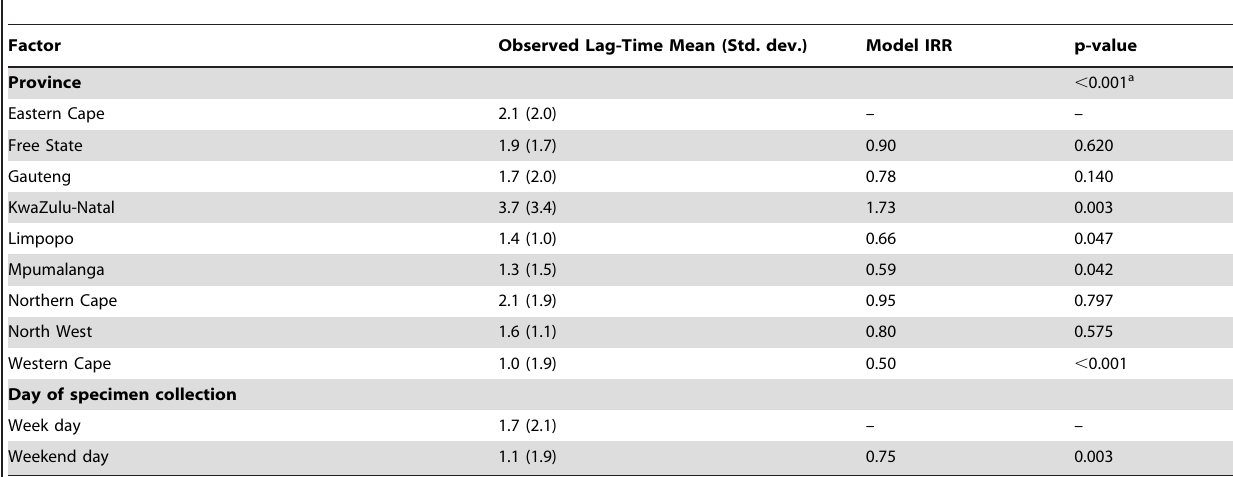
Table 1. Observed lag-time between date of symptom onset and date of specimen collection, incidence rate ratio (IRR) and significance value of the covariates significant in the Poisson regression model.